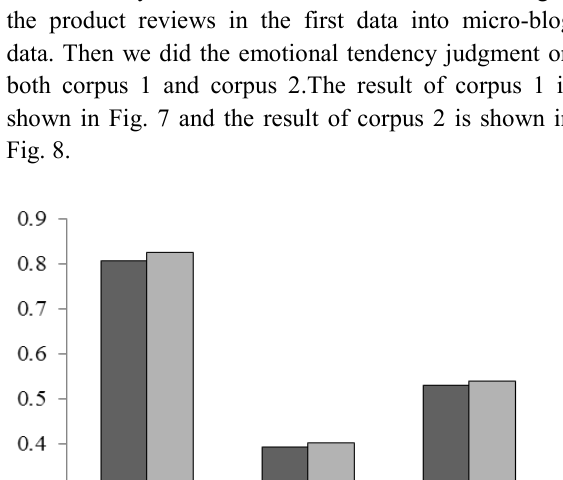
Fig. 6. Emotional tendency judgment result on micro-blog